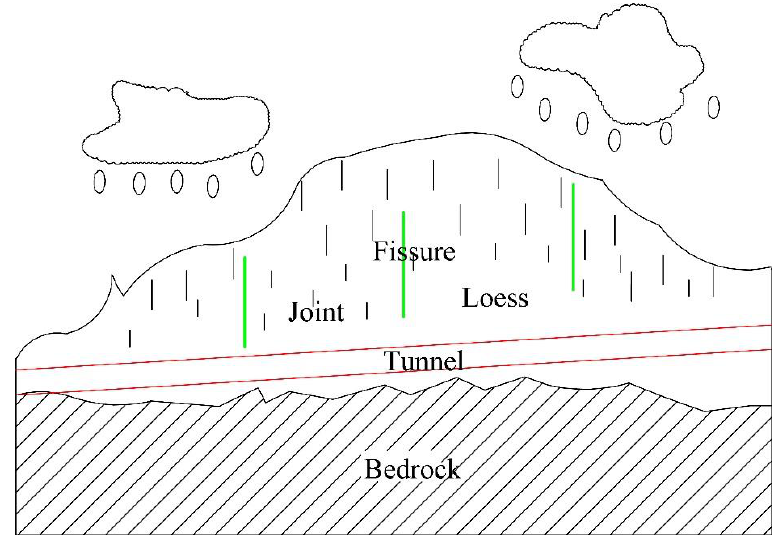
Figure 4. Surface rainfall infiltration into loess and tunnel.